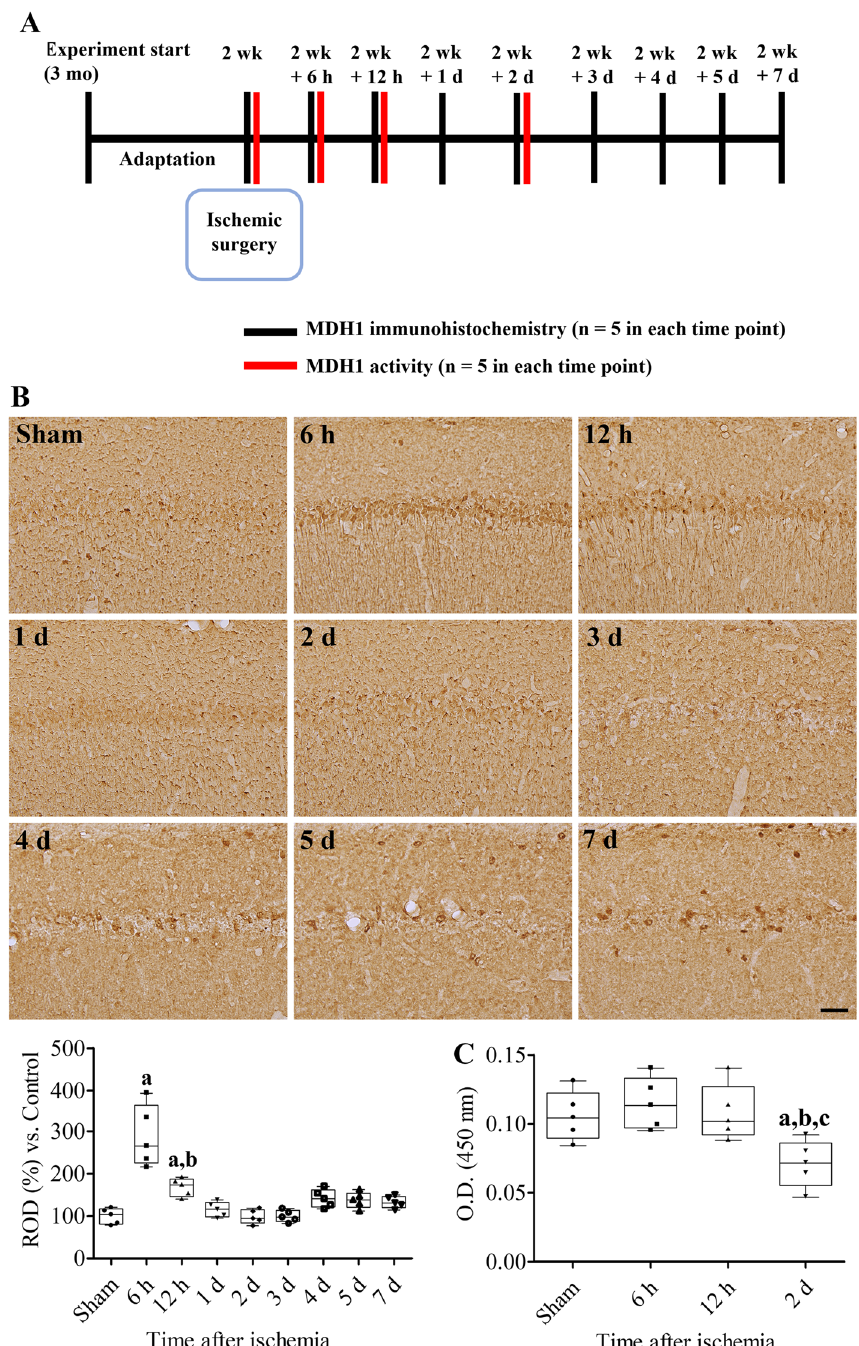
Figure 3. Chronological changes of MDH1 immunoreactivity and activity in the hippocampal CA1 region 5 min after ischemia in the gerbils. ( A ) Schematic drawing of the experimental study in MDH1 immunohistochemical staining and activity assay. ( B ) Spatial and temporal changes of MDH1 was assessed in the hippocampal CA1 region by immunohistochemical staining for MDH1. Scale bar = 50 μm. Optical densities are measured using ImageJ software and the relative optical density (ROD) are demonstrated as percentile values versus sham-operated group per section. ( C ) MDH1 activity was validated in the hippocampal homogenates using enzyme-linked immunosorbent assay (ELISA) kits 12 h and 2 d after ischemia. Data were analyzed using one-way analysis of variance followed by Tukey’s multiple comparison post hoc test ( a p < 0.05, significantly different from the sham-operated group; b p < 0.05, significantly different from 6 h post-ischemic group; c p < 0.05, significantly different from the 12 h post-ischemic group). Data are shown as mean + standard